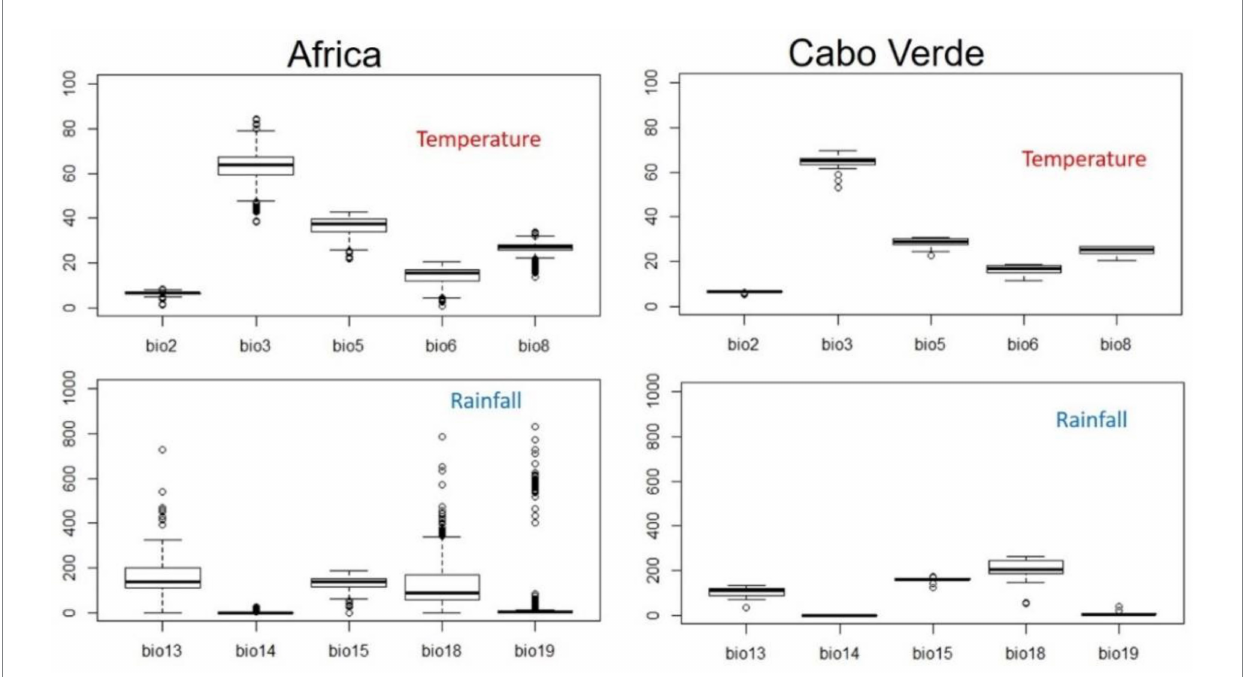
FIGURE 4 Descriptive values of bioclimatic variables used to model the distribution of Faidherbia albida in Cabo Verde, using data from mainland Africa to estimate its climatic niche. BIO2 (Mean Diurnal Range), BIO3 (Isothermality), BIO5 (Max Temperature of Warmest Month), BIO6 (Min Temperature of Coldest Month), BIO8 (Mean Temperature of Wettest Quarter), BIO13 (Precipitation of Wettest Month), BIO14 (Precipitation of Driest Month), BIO15 (Precipitation Seasonality), BIO18 (Precipitation of Warmest Quarter), BIO19 (Precipitation of Coldest